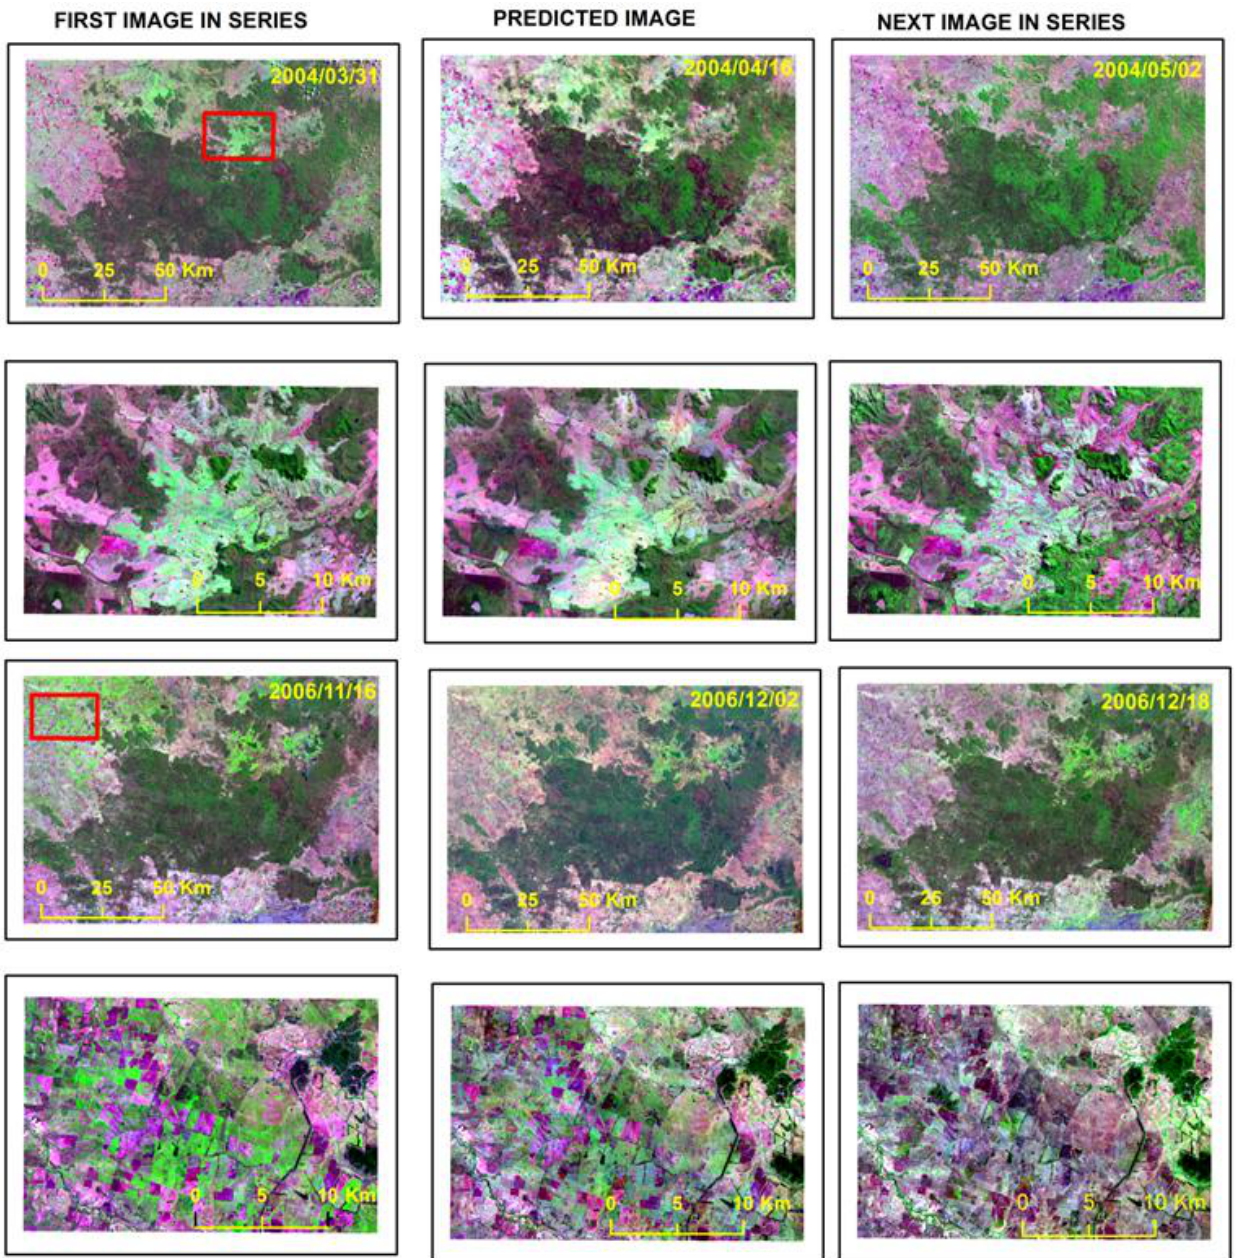
Figure 7. Comparison of predicted Landsat TM images band 5, 4 and 3 as red green and blue ( central column) with original images of earlier acquisition dates ( left column) and later acquisition dates ( right column). The second and last row shows the zoomed out area indicated by a rectangle in the first images of the earlier rows. It shows an example of predicted image capturing seasonal change in vegetation